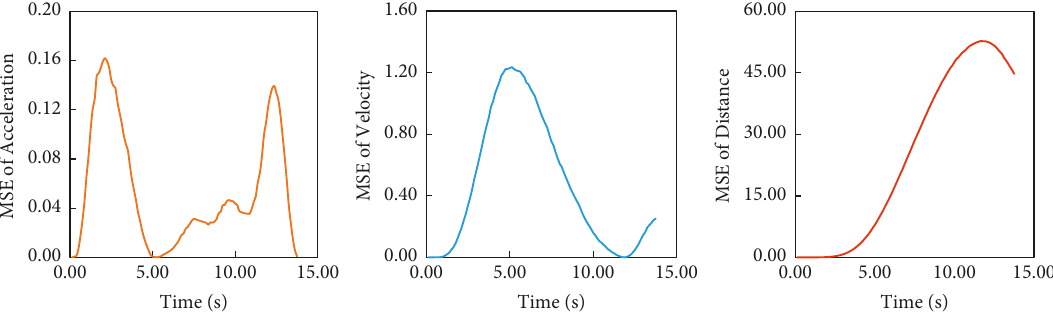
Figure 6: The curves of subject vehicle’s acceleration, speed, and distance during